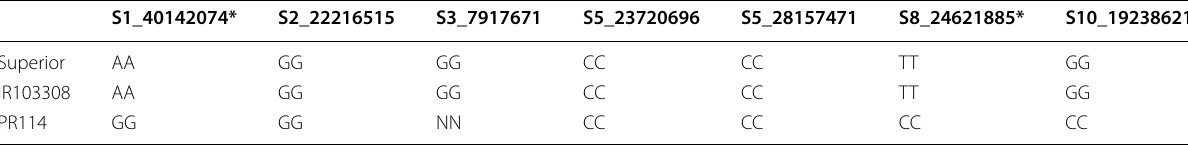
Table 6 The list of O. rufipogon accessions possessing combination of superior alleles at significant SNP positions associated with GW where SNPs marked with * represent alleles absent in indica